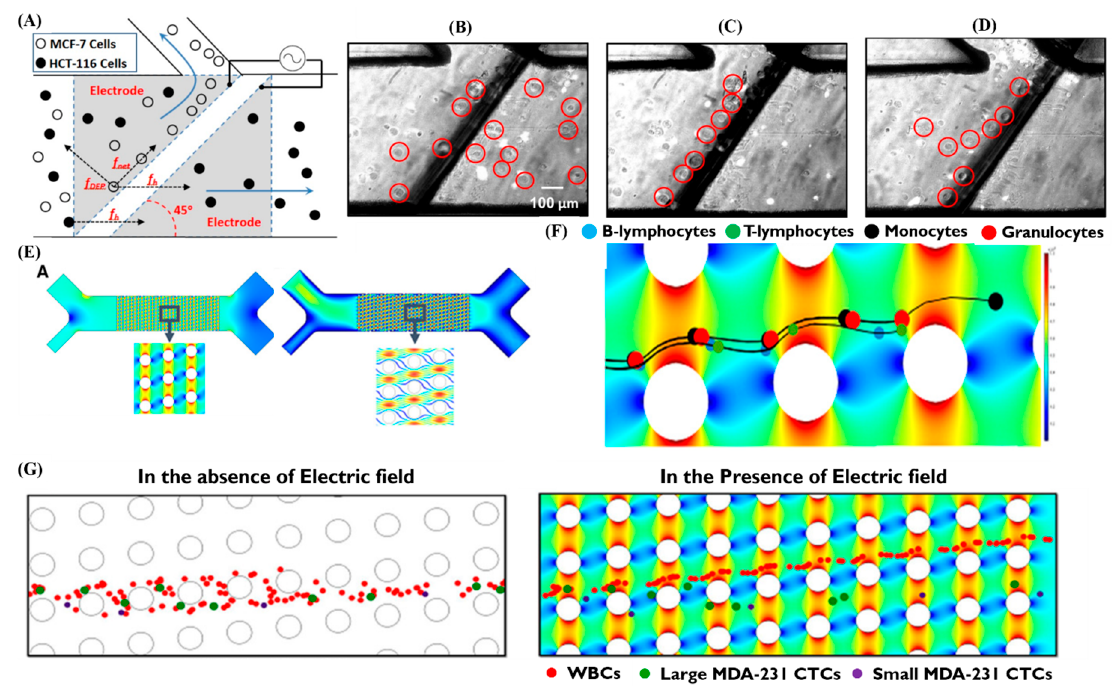
Figure 5. Application of DEP for separating CTCs. ( A ) Schematic of a dielectrophoretic lab-on-a-chip device was rely on a DEP and a hydrodynamic force. Arrows show flow through the main channel (80% infusion rate) and through the side channel (20% infusion rate), respectively. (B-D) The circles are used to mark MCF-7. ( B ) With no separation of the MCF-7 cells from the HCT-116 moved through the main channel without AC activation of the electrodes. ( C ) The MCF-7 cells are aligned parallel to the electrode (dark region) and are being deflected alone the side channel but the HCT-116 path is unchanged when the power source was turned on at 3.2 MHz. ( D ) Shows the system is really sensitive. Small changes in AC frequency is 2.0 MHz and can significantly change the results between the MCF-7 and HCT-116. [70] ( E ) Shows the electric field norm (left) and velocity field (right) of the DLD-DEP device. ( F ) Granulocytes, T-lymphocytes, B-lymphocytes, and monocytes were presented in the system and their paths were captured in the presence of applied electric field. ( G ) WBCs and CTCs’ trajectory in the absence of electric field (left), in the presence of electric field (right) by applying electric, CTCs can be separated from WBCs by changing the trajectory of WBCs. The design is capable of CTC separation from WBCs with similar size